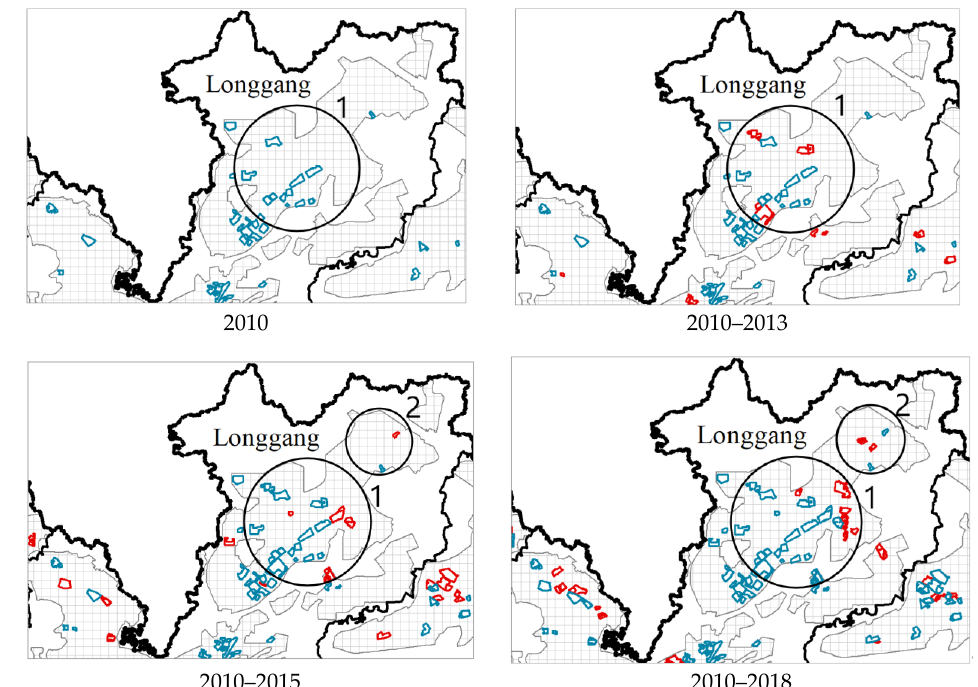
Figure 9. Annual cumulative statistically significant local spatial clusters of urban village redevelopment, 2010–2018.